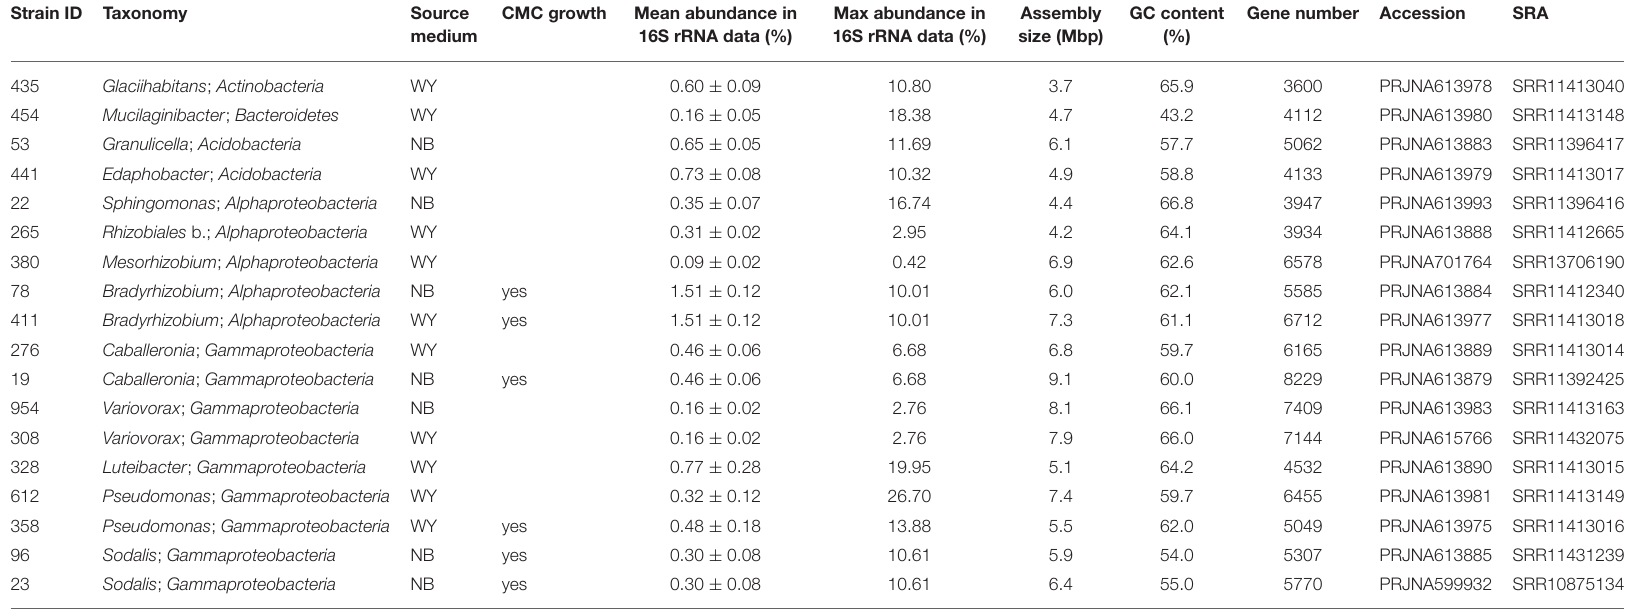
TABLE 1 | Genomic traits of dominant bacteria associated with decomposing